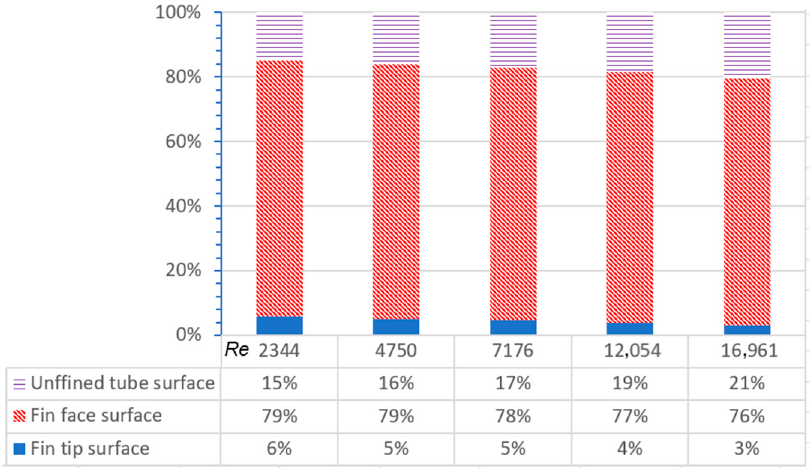
Figure 14. The share of heat rate on particular surfaces of the annular fin.